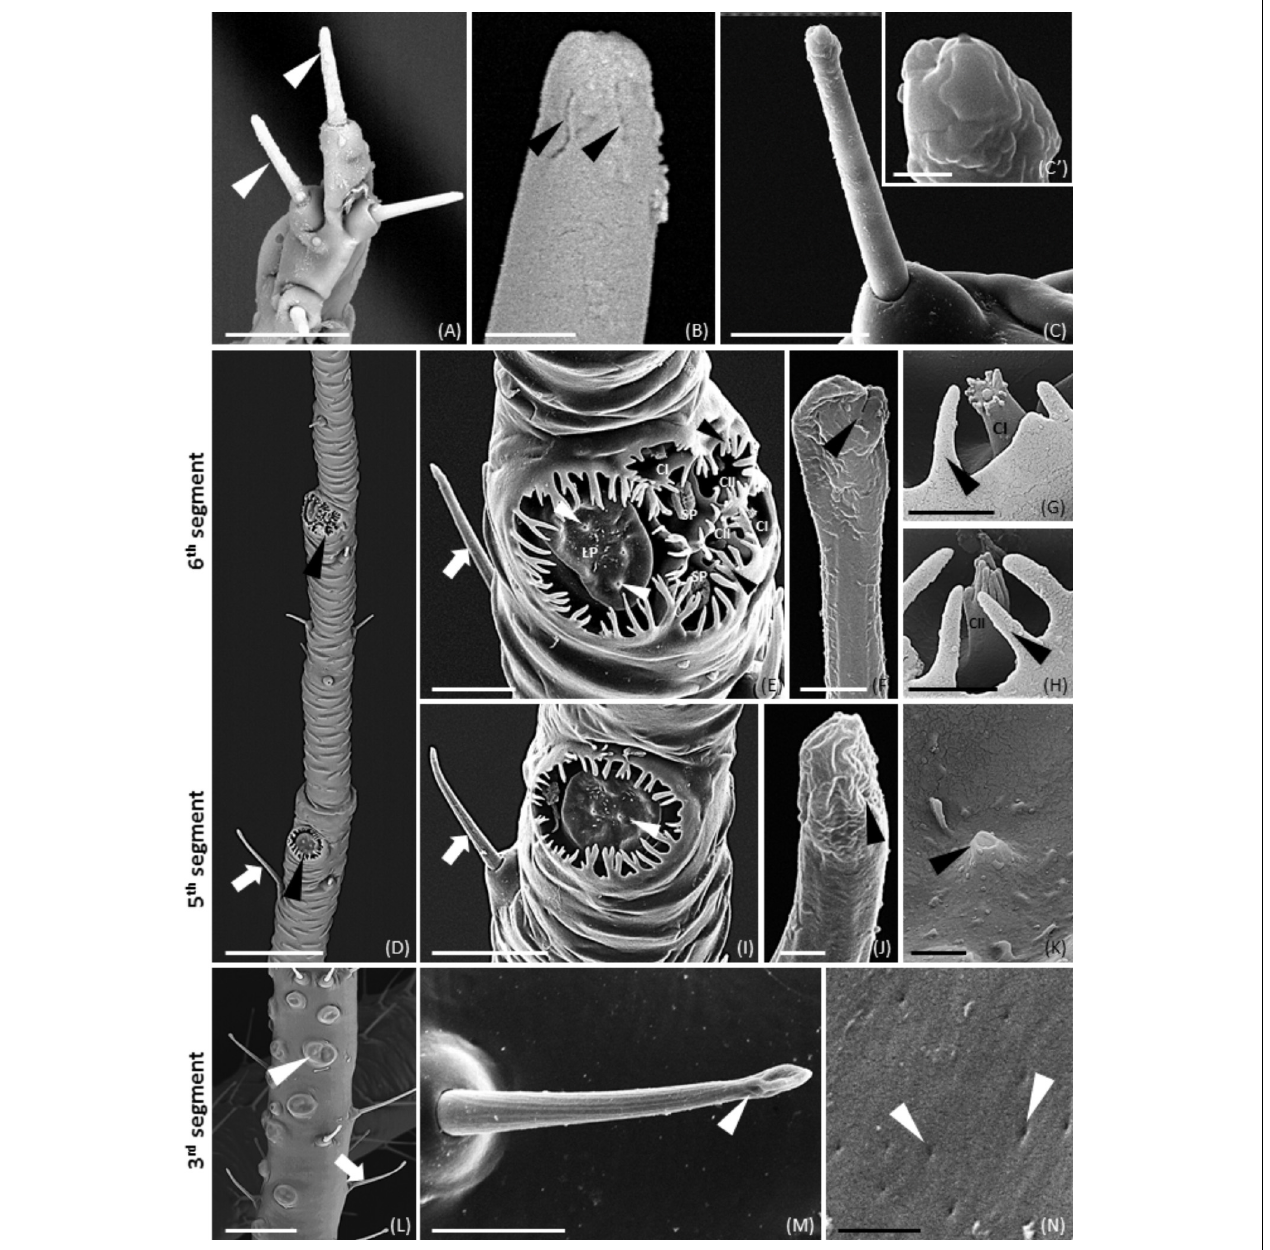
FIGURE 1 | SEM images showing the distribution and morphology of different sensilla on wingless M. viciae antennae. (A–C) Type II trichoid sensilla located on the terminal part of the antenna (arrowheads in (A) ), and on processus terminalis (C) showing a blunt tip with a grooved surface (B,C’) . (D) Global view of primary rhinaria on 5 and 6th segments (arrowheads) with a type I trichoid sensilla (arrow). (E) Details of the primary rhinaria on the 6th segment composed of 1 large placoid sensillum (LP) with porous structures (white arrowheads), 2 small placoid sensilla (SP), and 4 coeloconic pegs surrounded by cuticular fringes (black arrowheads). (G,H) Detail of type I (CI in (G) ) and type II (CII in (H) ) coeloconic sensilla in the 6th segment surrounded by cuticular fringes (arrowheads). (I) Detail of placoid sensillum of 5th segment. Porous structures were visible on the flat surface (arrowhead in (K) ). (L) Placoid sensilla forming the secondary rhinaria of the 3rd segment (arrowhead) and trichoid sensilla (arrow). (F,J,M) Details of type I trichoid sensilla showing a groove surface and porous structures on the tip. (N) Detail of a placoid sensillum with a smooth surface not surrounded by cuticular fringes and small pores on the flat surface. Bars in (A,E,I,M) , 10 µ m; bars in (B,F–H,K) , 1 µ m; bar in (C) , 5 µ m; bars in (C’,J,N) , 500 nm; bars in (D,L) , 50 µ m.